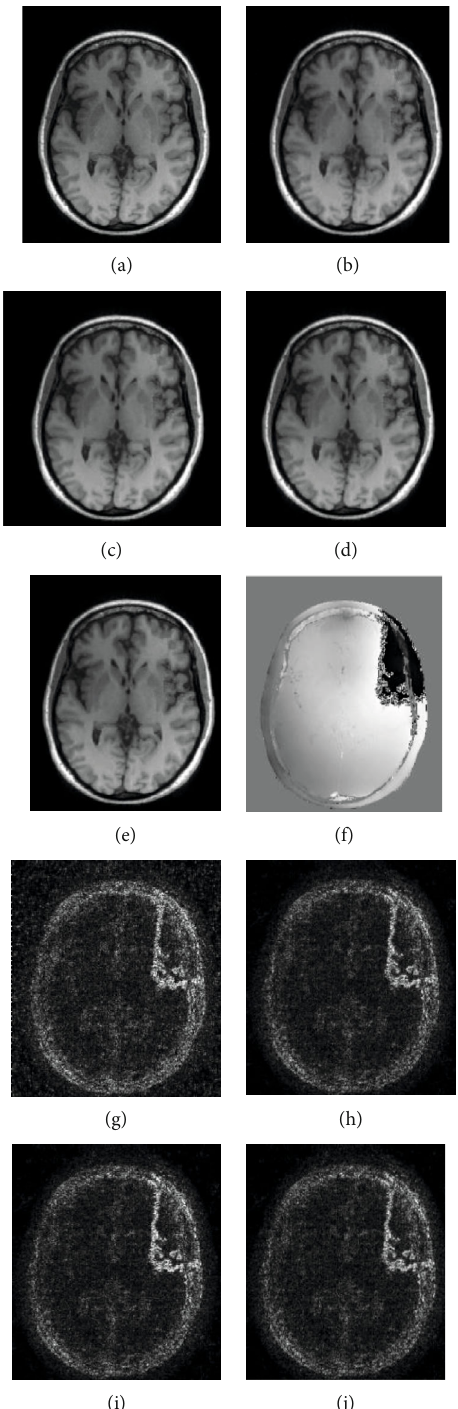
Figure 1: The (a) magnitude and (f) phase images are reconstructed directly from a full-sampled k -space brain dataset. Under 33% subsampling rate, the magnitude reconstruction results are shown in the upper row, respectively, by (b) FISTA, (c) ADMM, (d) SD [39], and (e) pFISTA [11]. And the below row displays the corresponding magnitude error maps of (g) FISTA, (c) ADMM, (d) SD, and (e)